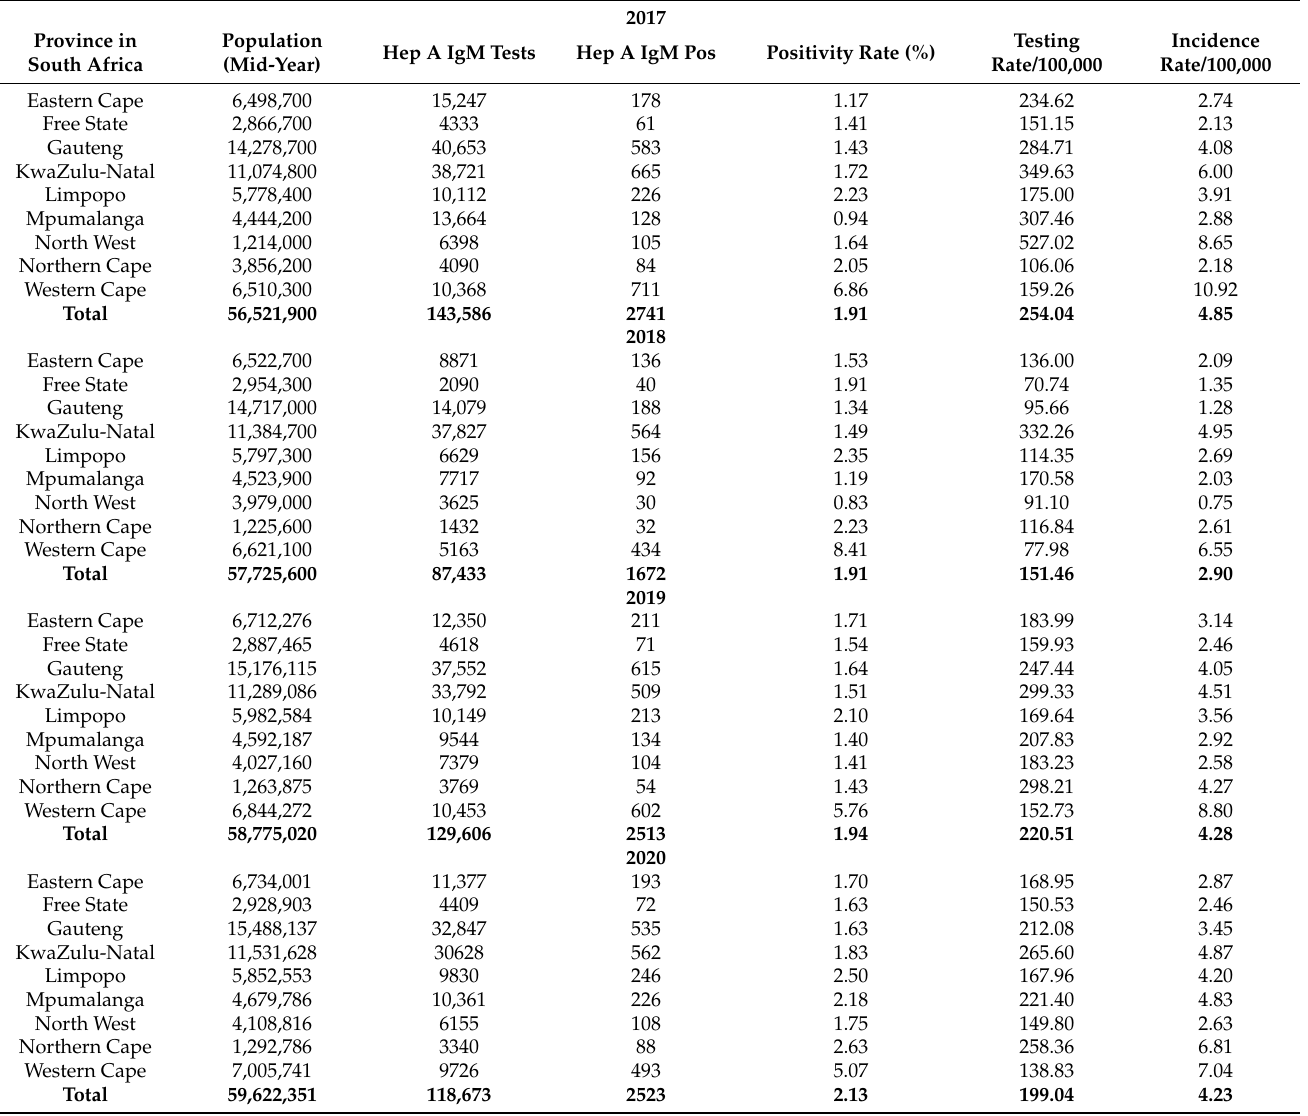
Table 1. National Hepatitis A positivity rate, incidence, and testing rate for years 2017 to